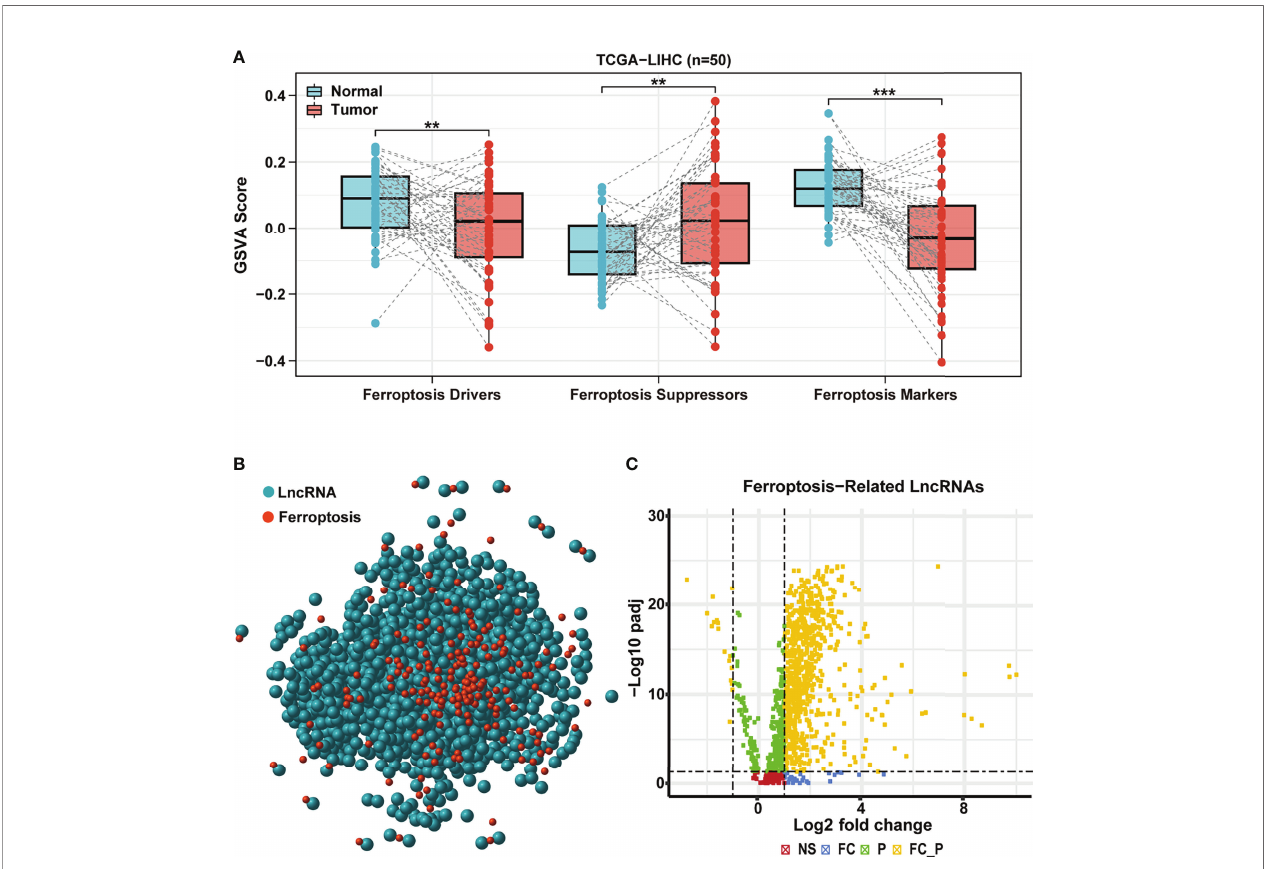
FIGURE 1 | Identi fi cation of differentially expressed ferroptosis-related lncRNA. (A) GSVA scores of ferroptosis drive, ferroptosis suppressor, and ferroptosis maker in paired samples of TCGA HCC cohort. (B) Correlation network of ferroptosis-related genes (red) and corresponding lncRNAs (blue). (C) The volcano plot for differentially expressed ferroptosis-related lncRNAs. Yellow dot represents signi fi cantly differentially expressed lncRNAs (|log2 fold-change| > 1 and FDR < 0.05). LncRNA, long non-coding RNA; GSVA, gene set variation analysis; TCGA, The Cancer Genome Atlas; HCC, hepatocellular carcinoma; FDR, false discovery